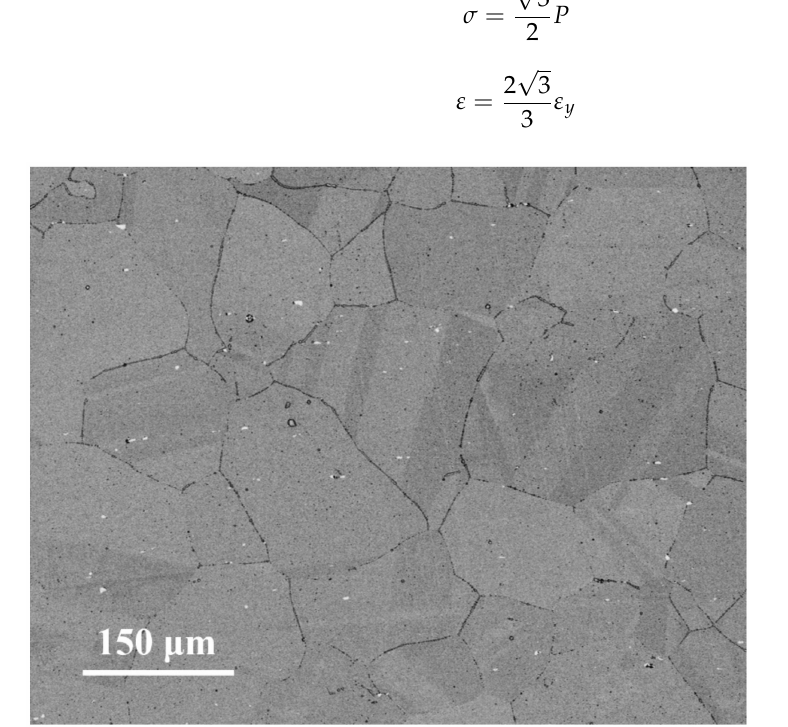
Figure 1. The original microstructure of annealed Inconel 625 characterized by